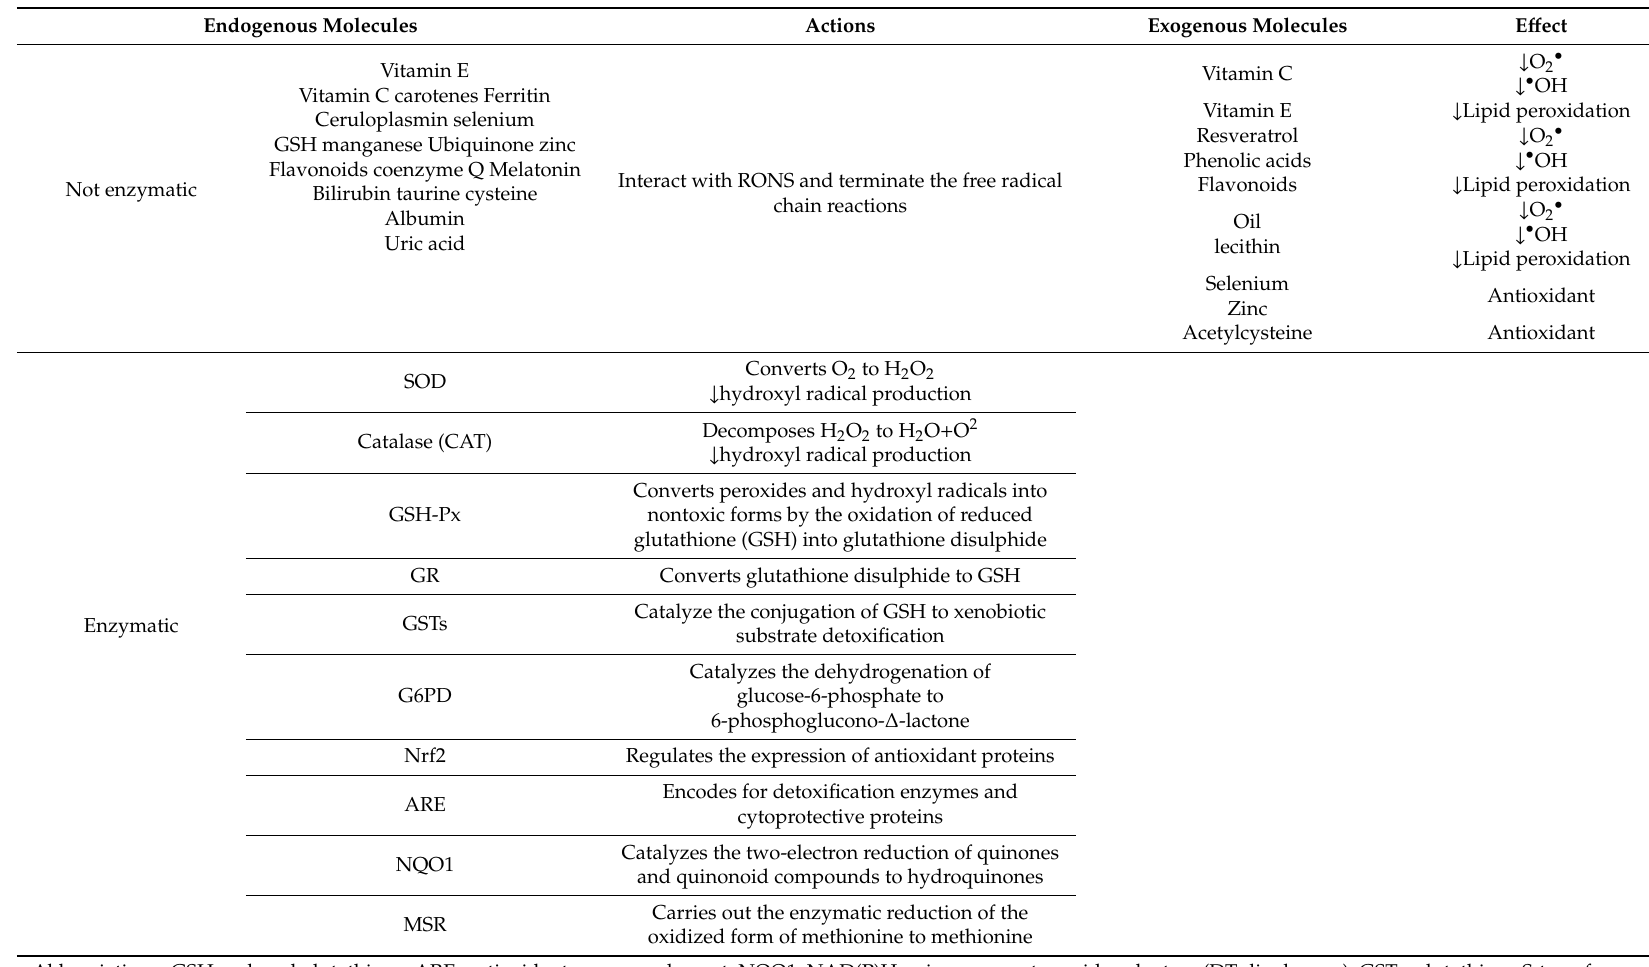
Table 5. Endogenous and exogenous molecules for counteracting free radicals (FRs) and reactive species toxicity. ↑ Means increase; ↓ means decrease /